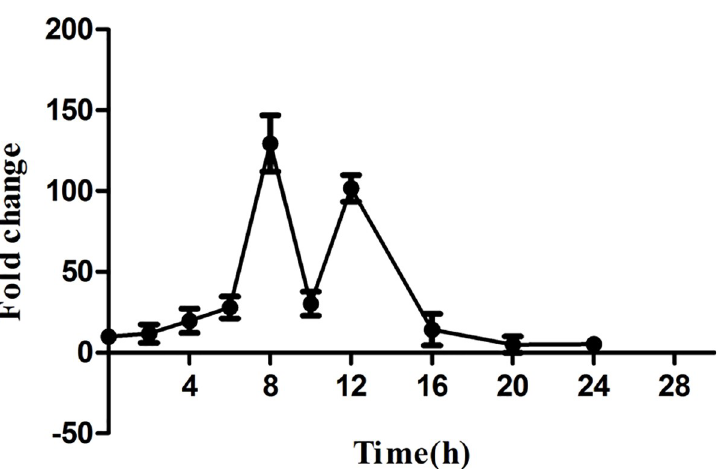
Fig 2. Tert expression during growth and development in D . discoideum . Tert is a single copy gene in Dictyostelium . Total RNA was extracted from Dictyostelium strain AX2 during vegetative growth and development. To analyze tert expression, qRT-PCR was carried out and the fold change was calculated. rnlA was used as a control. Time points are shown in hours (bottom). Error bars represent the mean and SEM (n = 3).